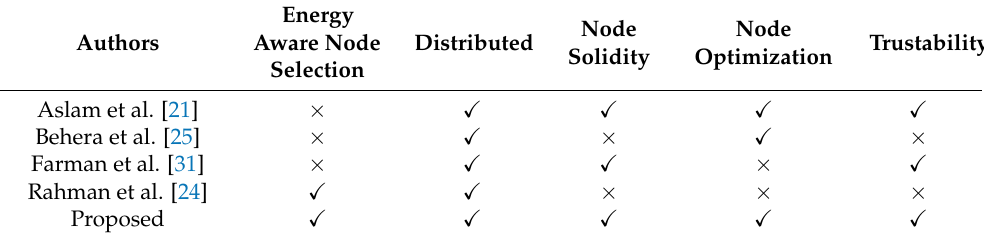
Table 1. The security performance comparison of different blockchain